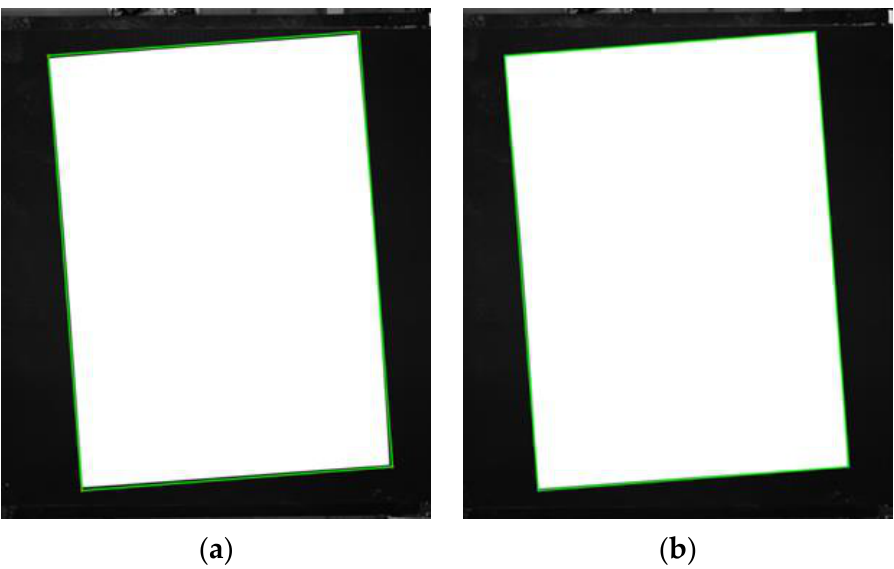
Figure 8. Image processing results of the calibration plate before and after distortion correction: ( a ) before distortion correction and ( b ) after distortion correction.